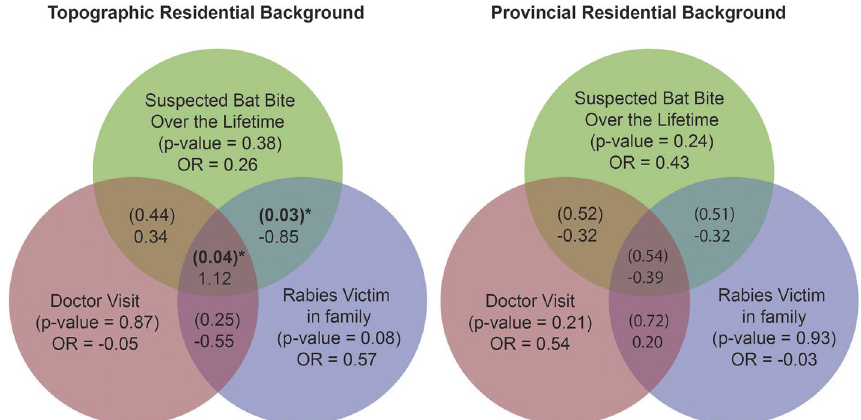
Fig. 2 Risk prediction in bat human interactions for two different residential background, A Cross-Sectional Survey on Fruit Bat-Human Interaction in Pakistan; One Health Perspective,